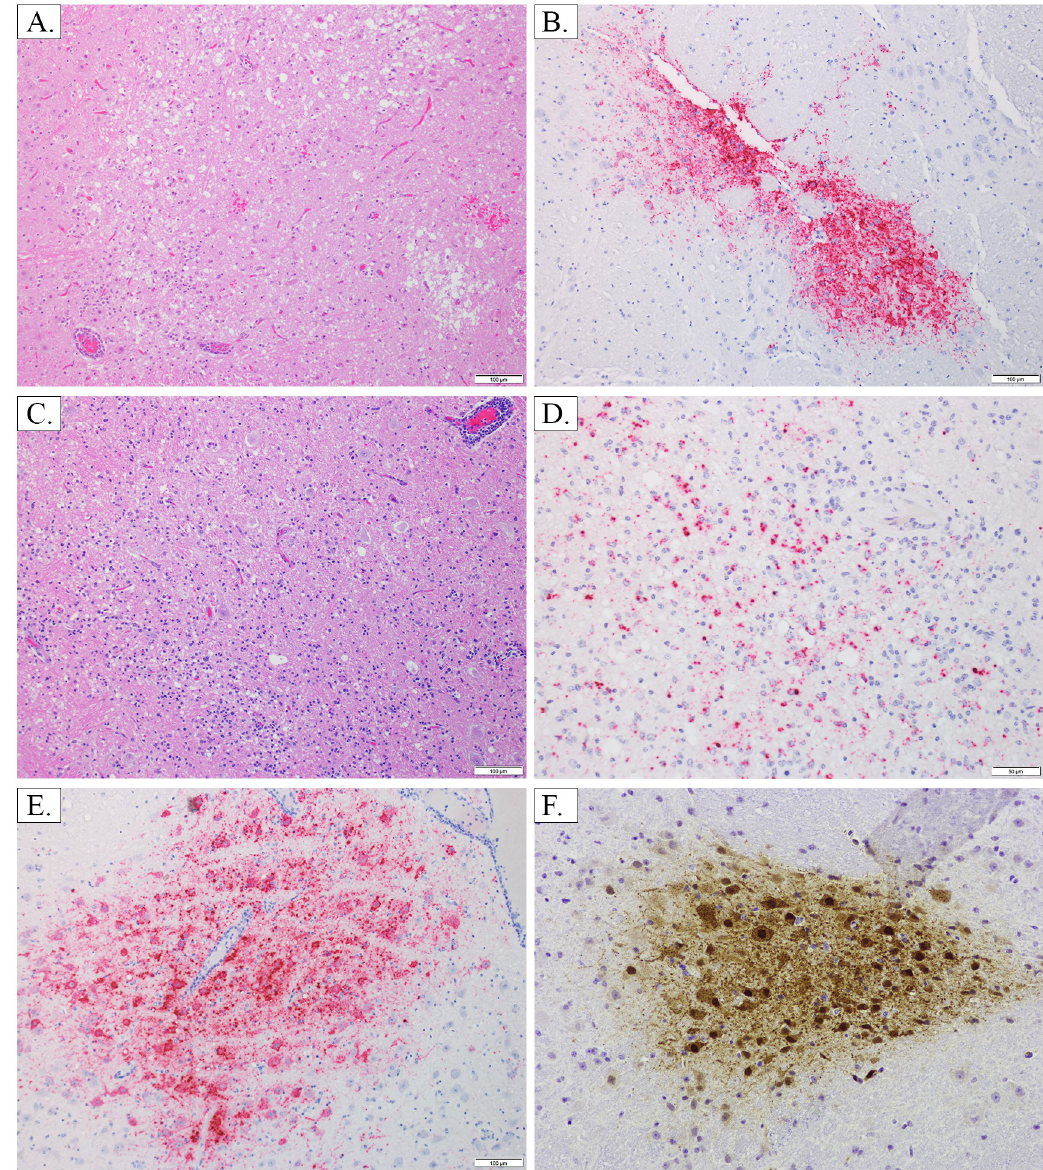
Fig 6. Brain- H&E, IHC, ISH. Image A, AGM 1, brain, pons 10X H&E: Focally extensive area of spongiosis and rarefaction of neuropil with gliosis, hemorrhage and perivascular cuffing. Image B, AGM 1, brain, pons 10X ISH: NiV labeling in the neuropil, glia and neuron cytoplasm in an area of neuropil rarefaction and gliosis (roughly corresponding to image A). Image C, AGM 4, brain, medulla 10X H&E: An area of moderate gliosis and inflammation with perivascular cuffing and spongiosis. Image D, AGM 4, brain, medulla 20X ISH: NiV labeling in an area of inflammation and gliosis (roughly corresponding to image C). Image E, AGM 4, brain, pons 10X ISH: NiV labeling in the neuropil, neuron cytoplasm and glia in an area without significant inflammation or gliosis. Image F, AGM 4, brainstem, 20X IHC: Positive NiV labeling in neurons and adjacent neuropil.